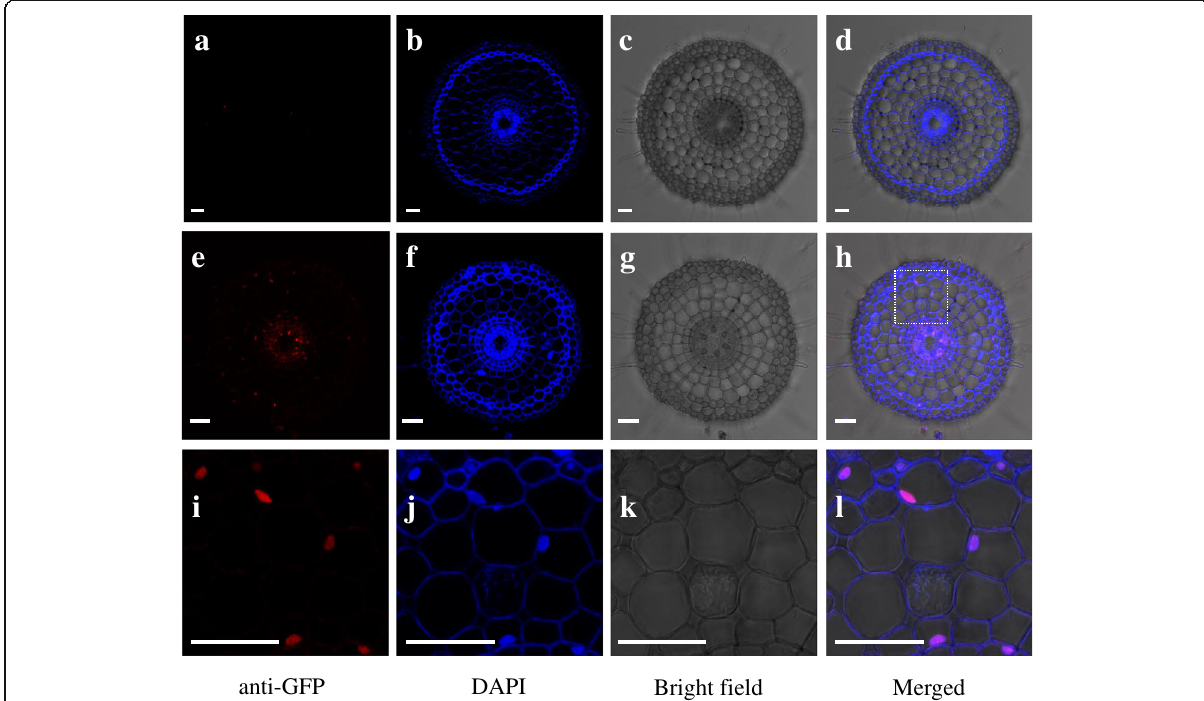
Fig. 2 Subcellular and cellular localization of OsNAC45. a - d Immunostaining of the roots of Nipponbare using the anti-GFP antibody. e - h Immunostaining of the roots of Pro OsNAC45-OsNAC45-GFP transgenic plants. i - l High-magnification images of dotted part in ( h ). Red color indicates the signal of the anti-GFP antibody, blue color indicates autofluorescence of cell wall and nuclei stained with DAPI. Scale bar = 20 μ m